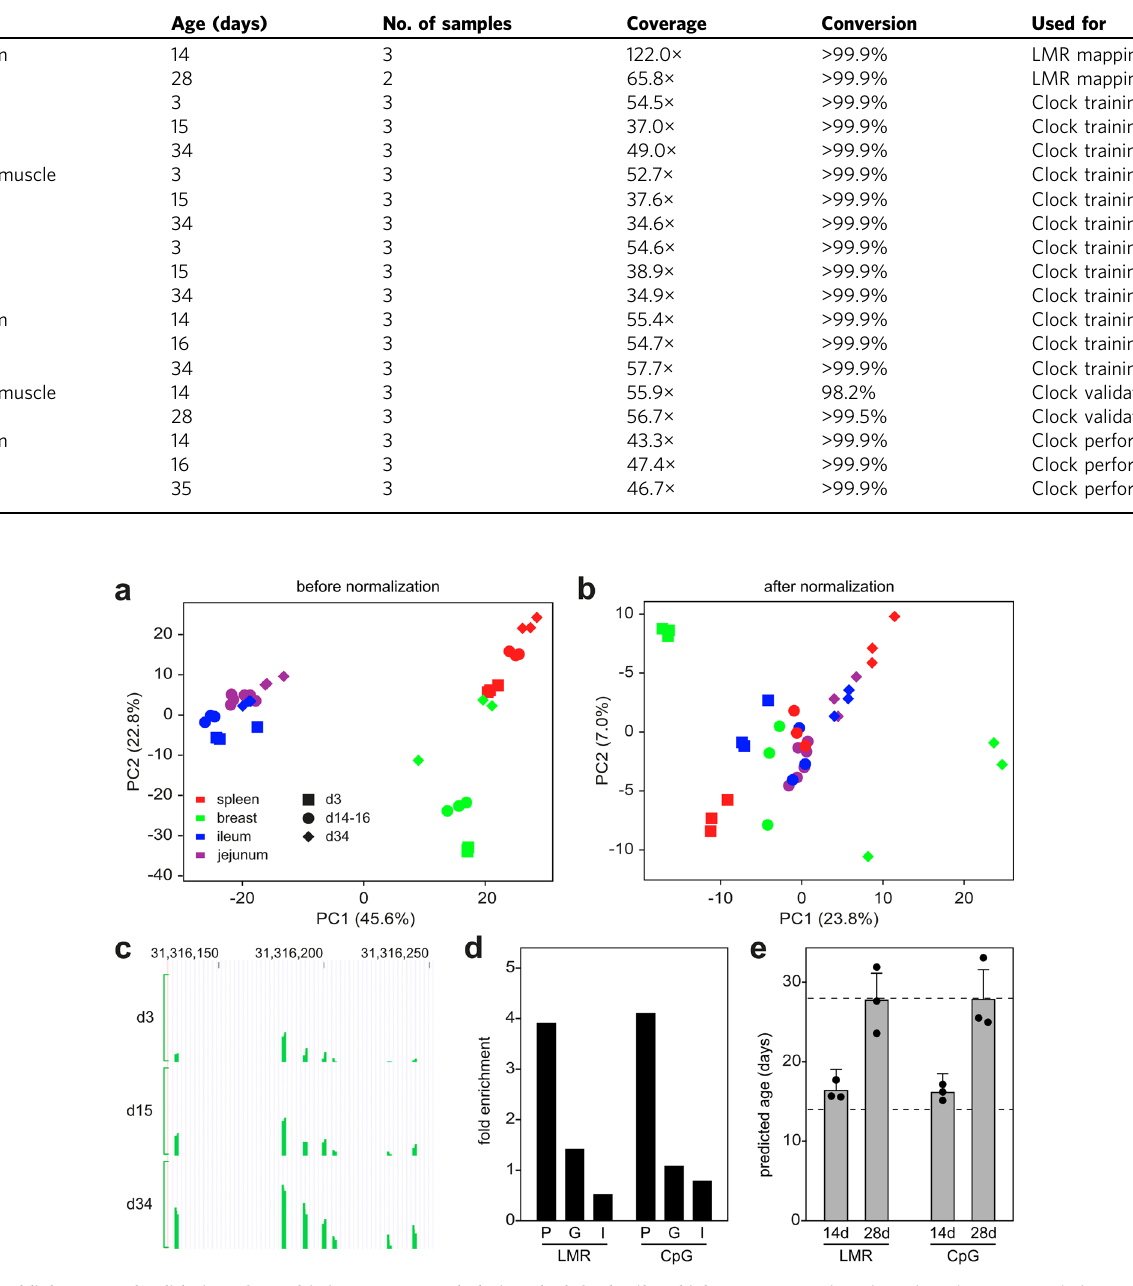
Fig. 4 Establishment and validation of a multi-tissue DNA methylation clock for broiler chicken. a PCA analysis based on the DNA methylation patterns of 67,651 LMRs in the training set ( N = 36 samples). b PCA based on LMR methylation patterns after fi ltering and normalization. c Example of a highly weighted clock LMR from the Igfbp3 gene body (#5 in Tab. S4), showing progressive age-related methylation. Coordinates refer to chromosome 2 of chicken genome assembly (version 5.0). Green lines indicate methylation levels from 0 to 1. d Enrichment of clock LMRs and clock CpGs in speci fi